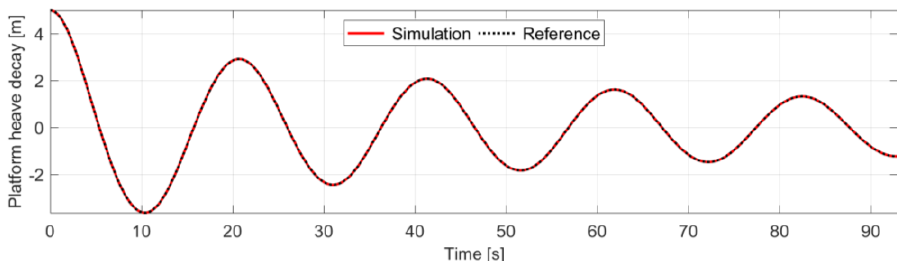
Figure 3. Time series of the heave free-decay test.